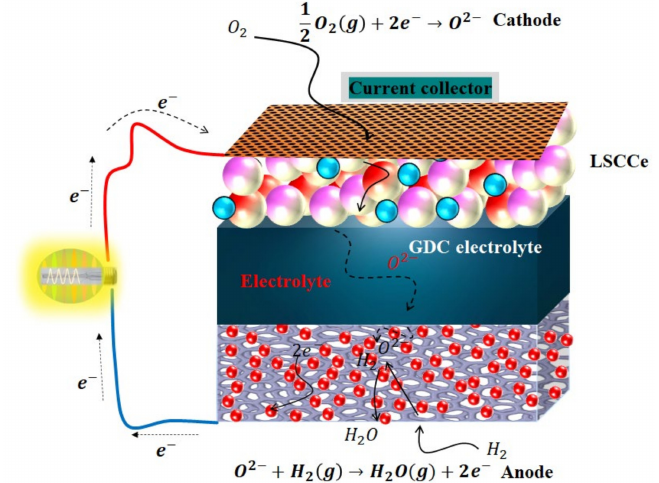
Figure 8. Schematic diagram of the different steps for electrochemical processes from fuel, con- verting the fuel energy into electricity from La/Ce-doped SrCoO 3 -based cathode fuel cell over GDC